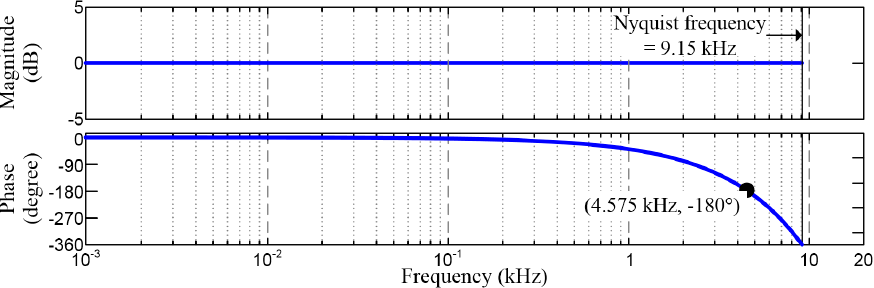
Figure 10. The frequency response of the deadbeat current controller without voltage limitation.